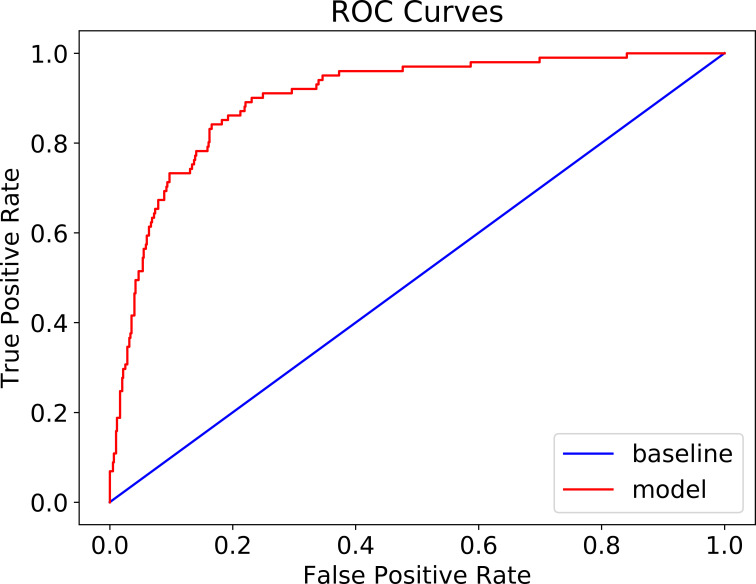
ROC curve of mortality prediction (AUC: 90%).